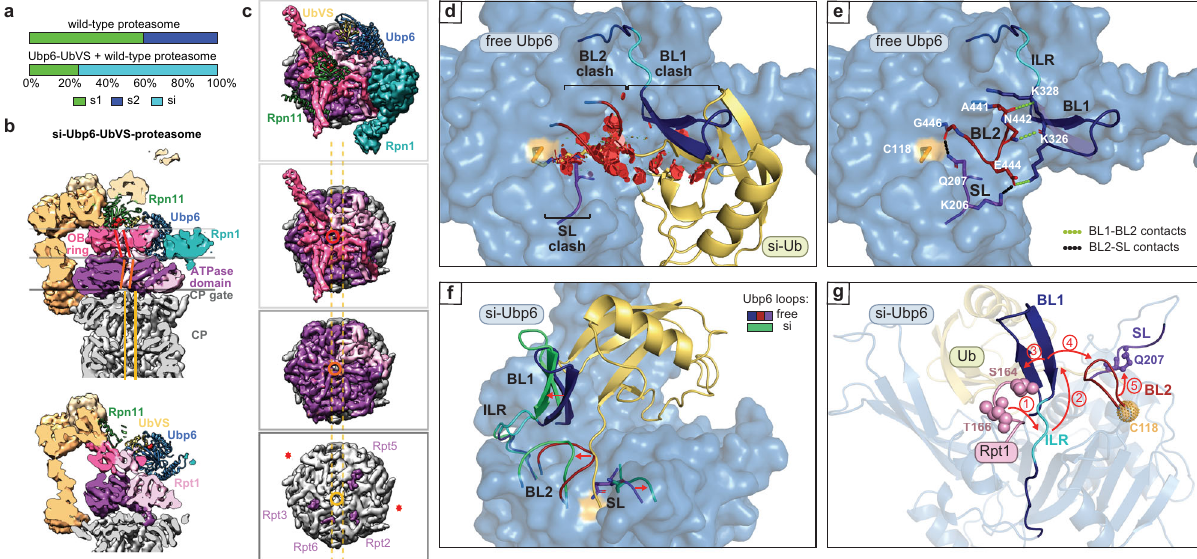
Fig. 5 The inhibitory Ubp6-UbVS-proteasome complex de fi nes a new conformational state of the proteasome. a Ubp6-UbVS induces the si proteasome state. b Cross-section of the cryo-EM density map of the si state proteasome at 7.0 Å resolution for the ATPase domains including Ubp6 and 6.1 Å for the rest. Misaligned axial channels of the OB ring, the ATPase domain ring, and the CP are denoted by parallel bars (red, orange, and yellow, respectively). Rpn11 (green) is misaligned with the OB domain substrate entry port. Horizontal lines indicate cutting planes in c . Bottom: alternative z-plane visualizes Ubp6 catalytic domain. Active sites of Ubp6 and Rpn11 are highlighted in red, proteasome subunits as in Fig. 1a. c Cut-away views down the long axis of si proteasome from the OB ring to the ATPase domain ring to the CP α -ring. Subunits of interest are highlighted. RP axial channels are off-axis to the CP (dotted yellow lines). The OB substrate entry port is circled in red, ATPase translocation channel in orange. Four C-terminal Rpt tails (Rpt2, Rpt6, Rpt3, Rpt5) are inserted into CP α pockets. Asterisks: unoccupied α pockets. d Occlusion of ubiquitin by BL1, BL2, and SL in free Ubp6 illustrated by red disks (PDB: 1VJV). Ubiquitin is modeled onto free Ubp6, positioned as in complex si. e BL1-BL2-SL network in free Ubp6 (PDB: 1VJV) is established through interloop contacts. f Comparison of the blocking loop network in free Ubp6 (PDB: 1VJV) and complex si. Loops from free Ubp6 are superimposed onto si- Ubp6. The structure is rotated 90° counterclockwise from d . g Proposed cascade of signal transfer within Ubp6 upon interaction with